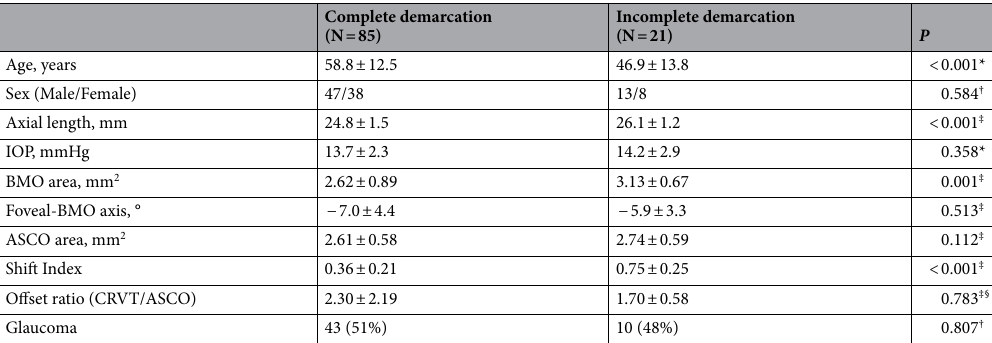
Table 1. Demographic data according to completeness of anterior scleral opening (ASCO) demarcation. IOP, Intraocular pressure; BMO, Bruch’s membrane opening; ASCO, Anterior scleral canal opening; CRVT, Central retinal vascular trunk. *Comparison performed using independent- t test. † Comparison performed using Chi- square test. ‡ Comparison performed using Mann–Whitney U test. § Eyes with shift index = 1.0 were excluded, since we could not precisely determine the extent of CRVT